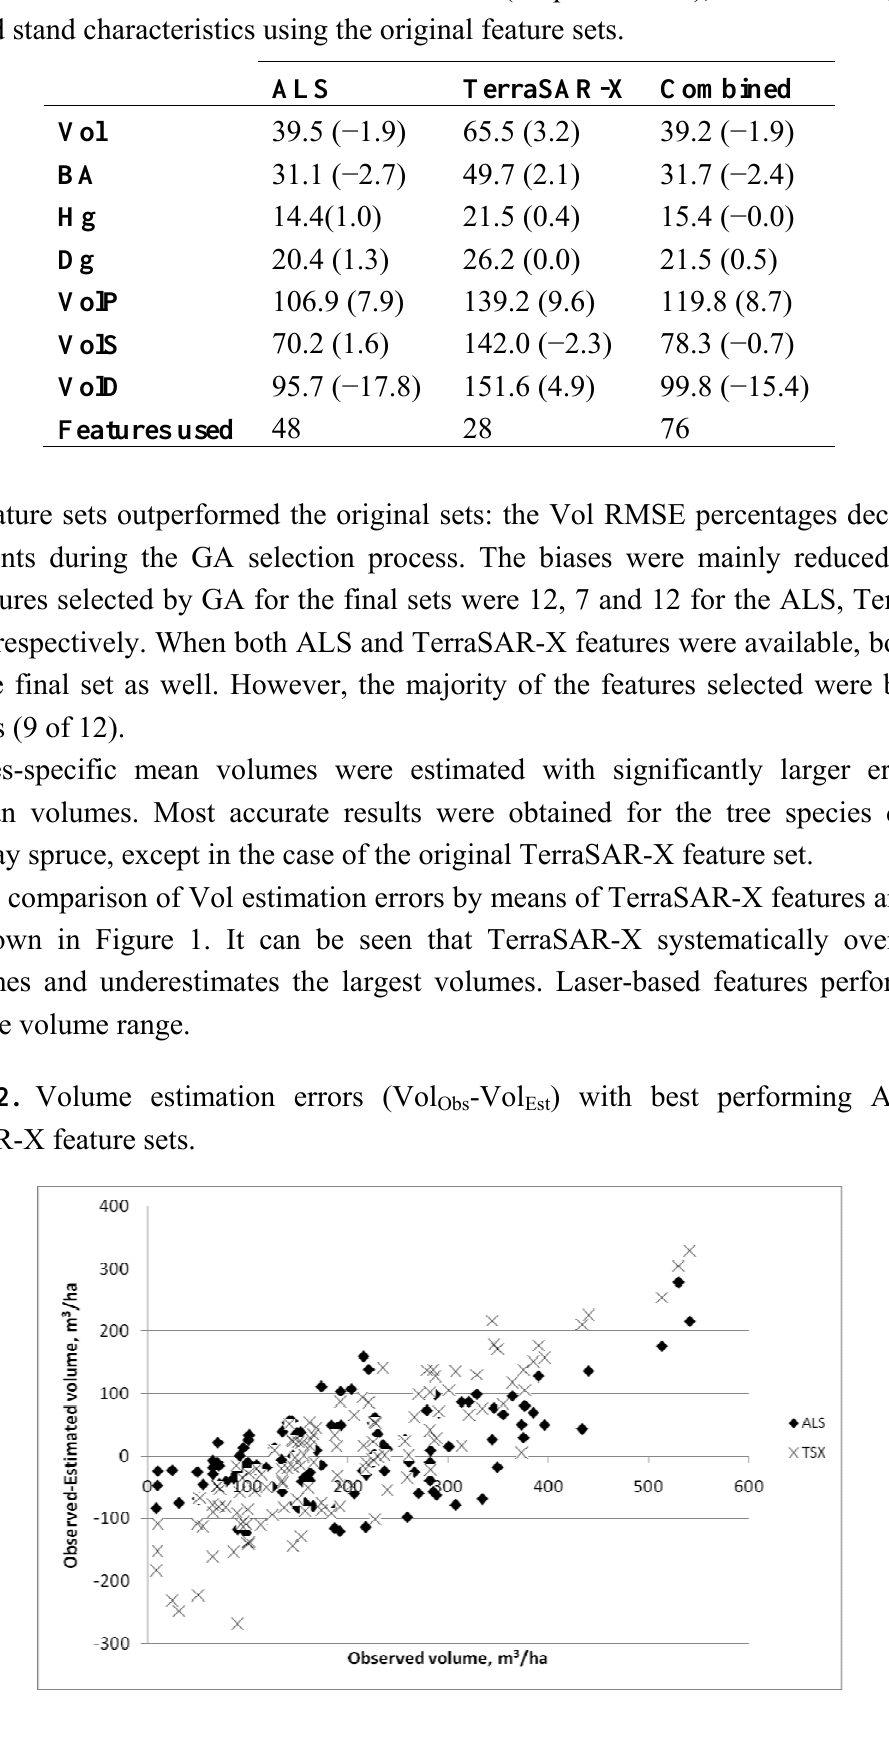
-Vol ) with best performing ALS and Obs Est